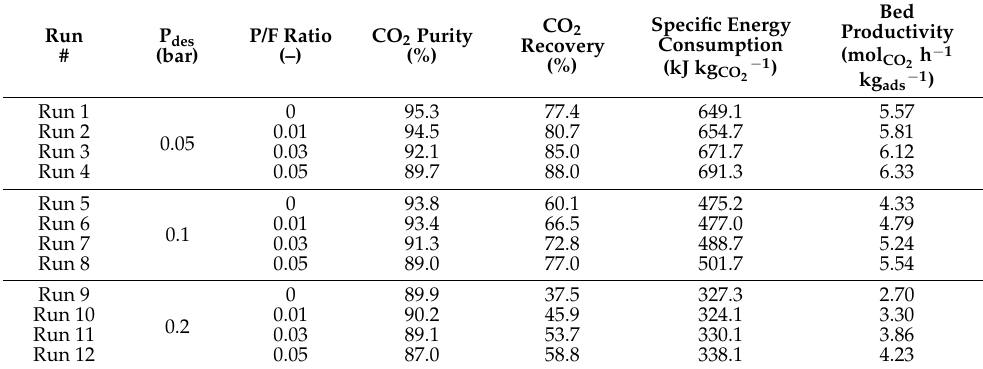
Table 3. Performance results of the 2-bed, 4-step VPSA